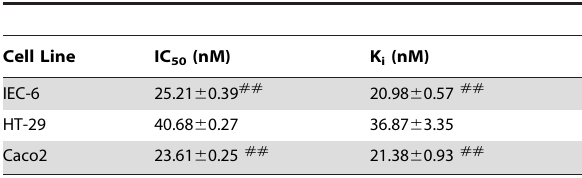
Table 2. Receptor-ligand binding affinities and IC 50 values for epithelial cells (n =6).